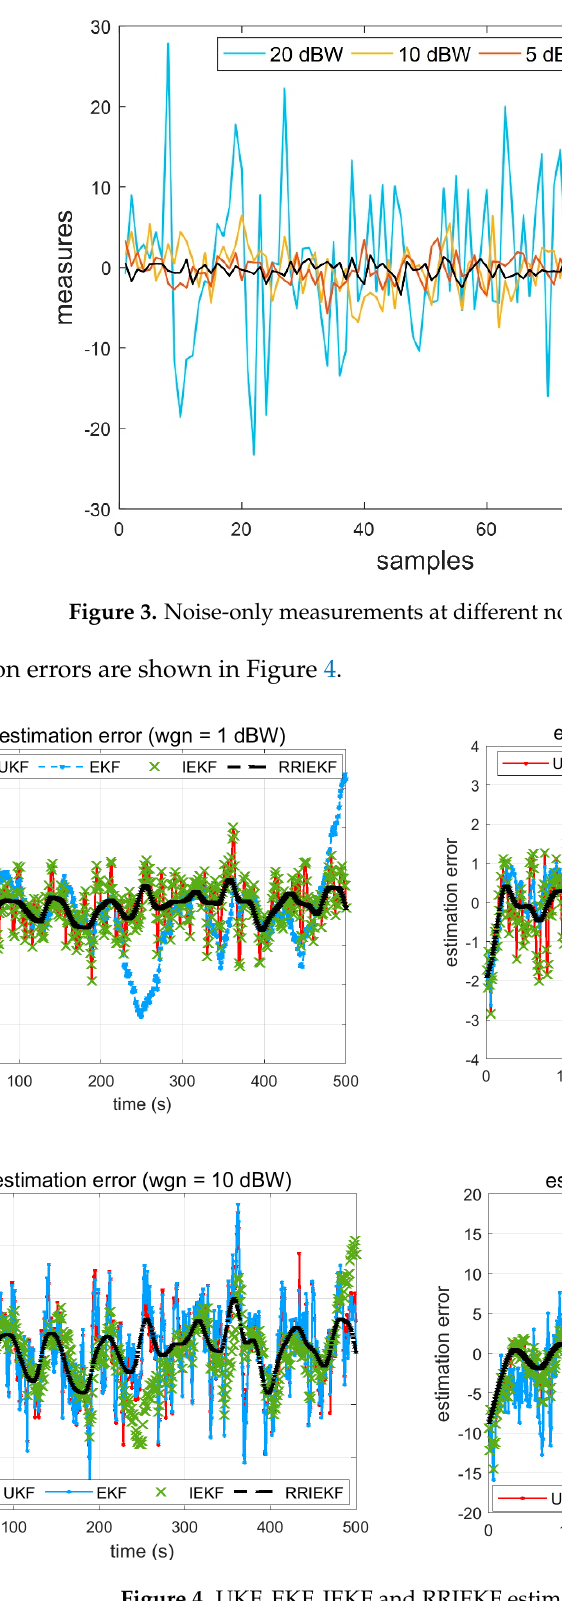
Figure 4. UKF, EKF, IEKF and RRIEKF estimation errors.